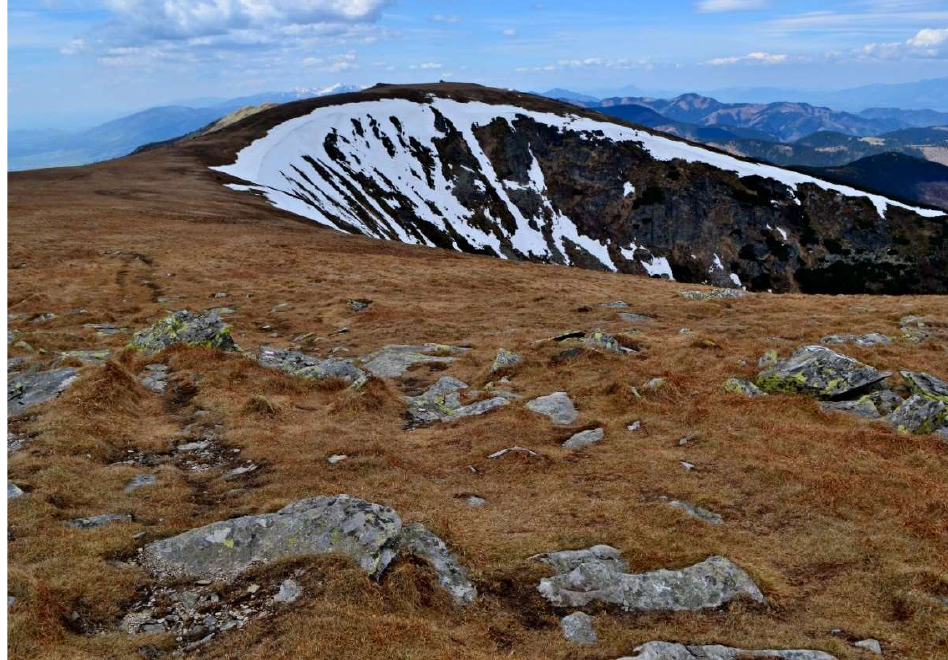
Figure 12. Identification of a trigger zone located along the edge of the glacial cirque Veľký Brunov.